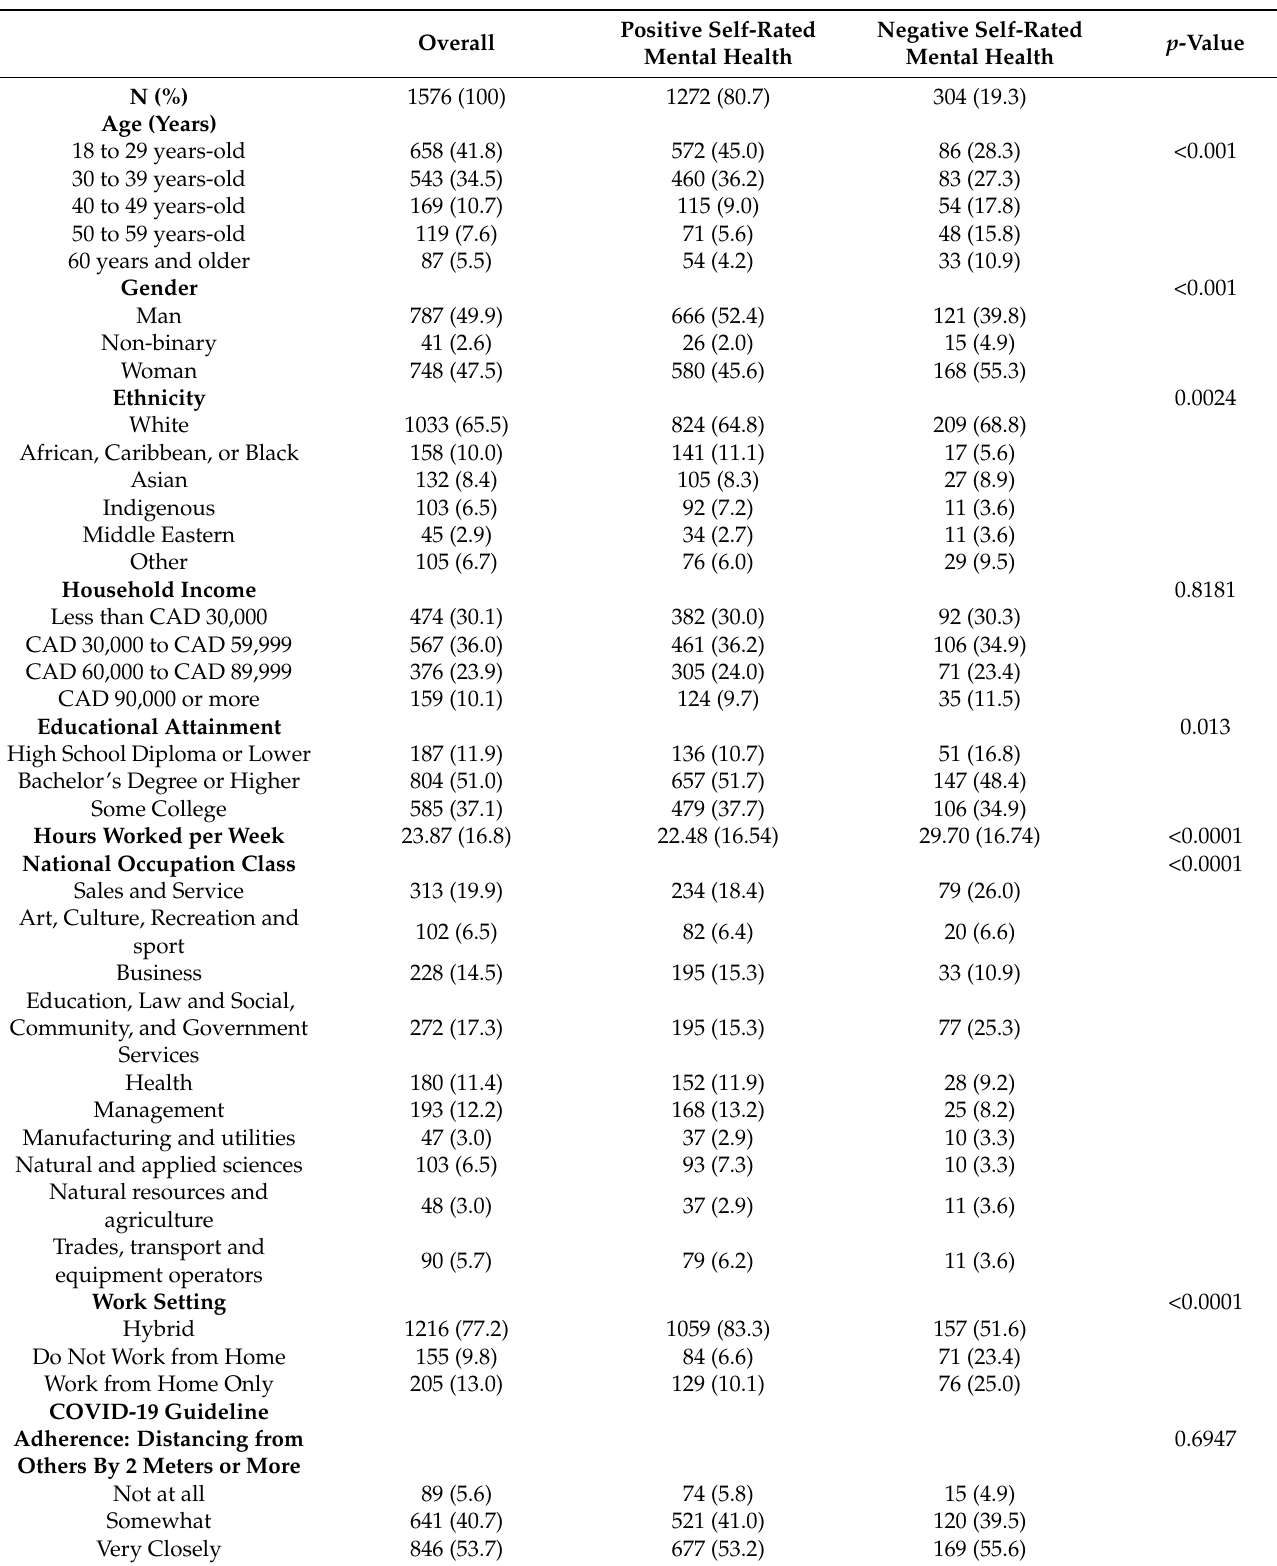
Table 1. Sample Characteristics Stratified by Self-Rated Mental